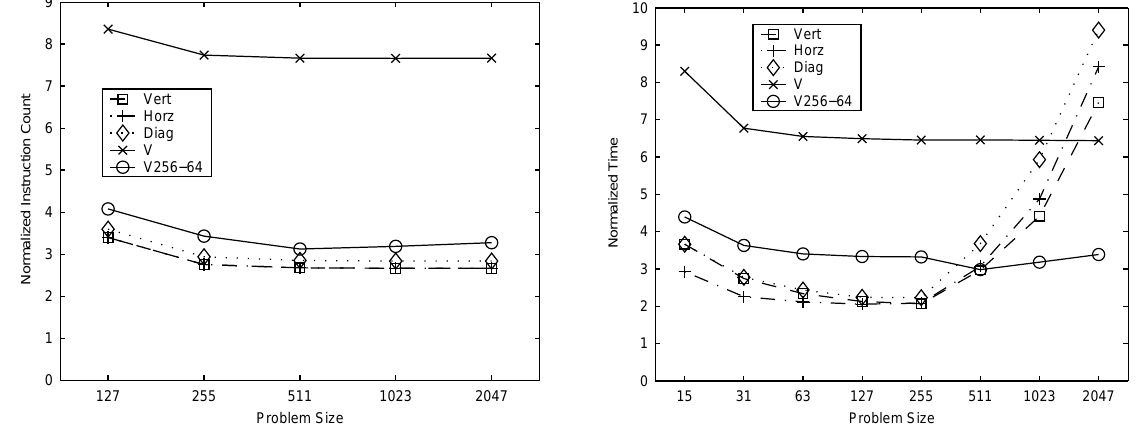
Fig. 2: Normalized instructions (left) and time in nanoseconds (right) are plotted for the five algorithms.